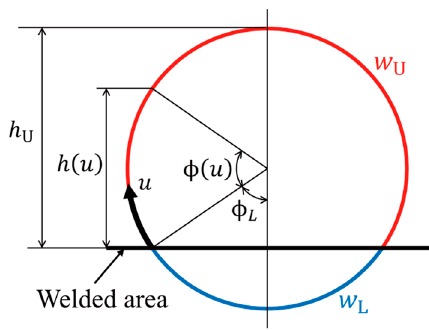
Figure 5. Cross-section of the curved state (ring cut